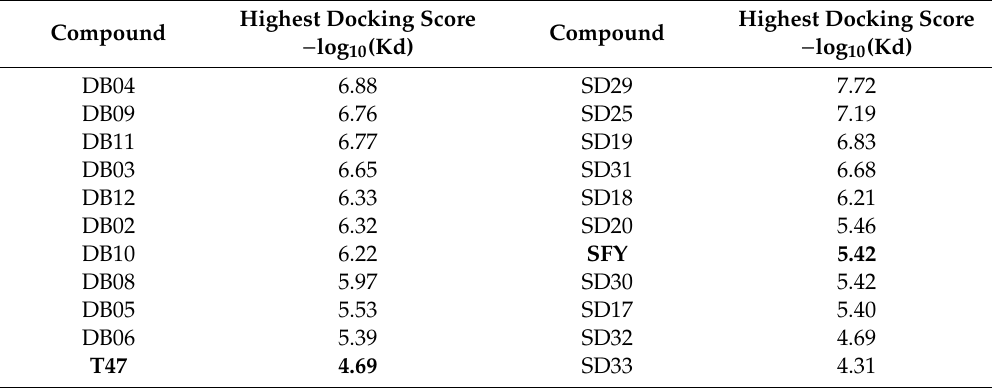
Table 5. Docking Scores for nitrogen-containing heterocycle derivatives of T47 and SFY. Highest Docking Score Compound − log 10 (Kd)